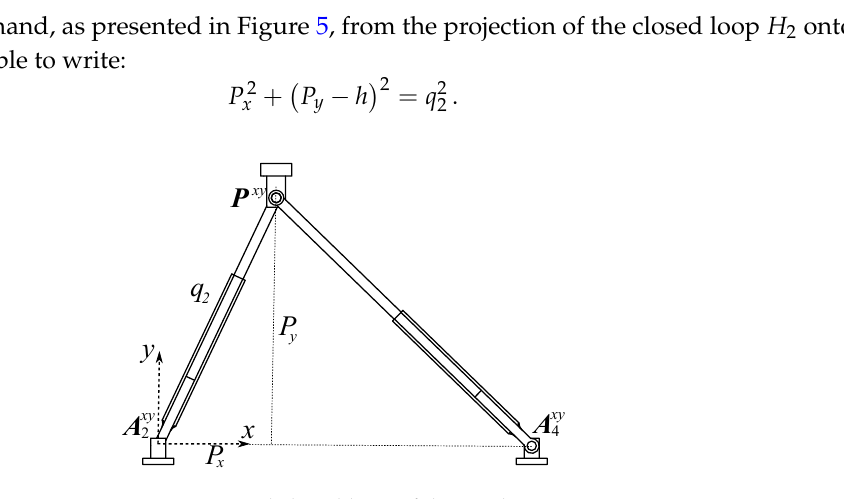
Figure 5. Second closed loop of the